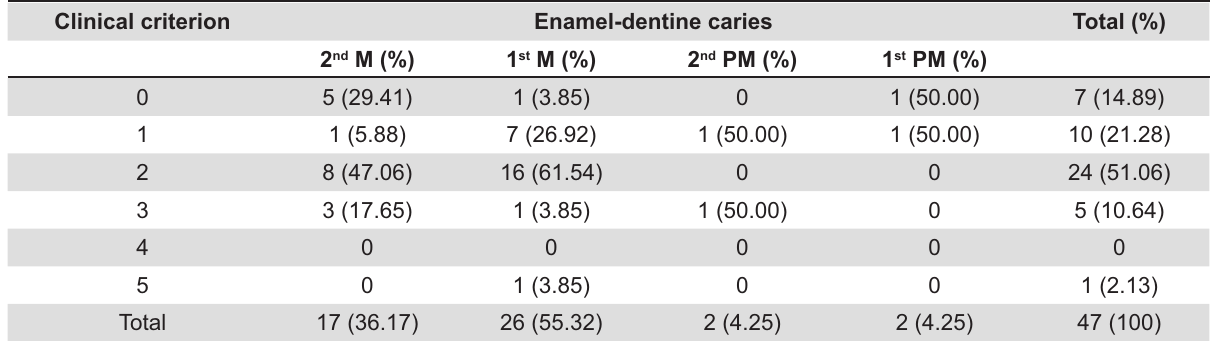
(M= molar; PM= premolar)